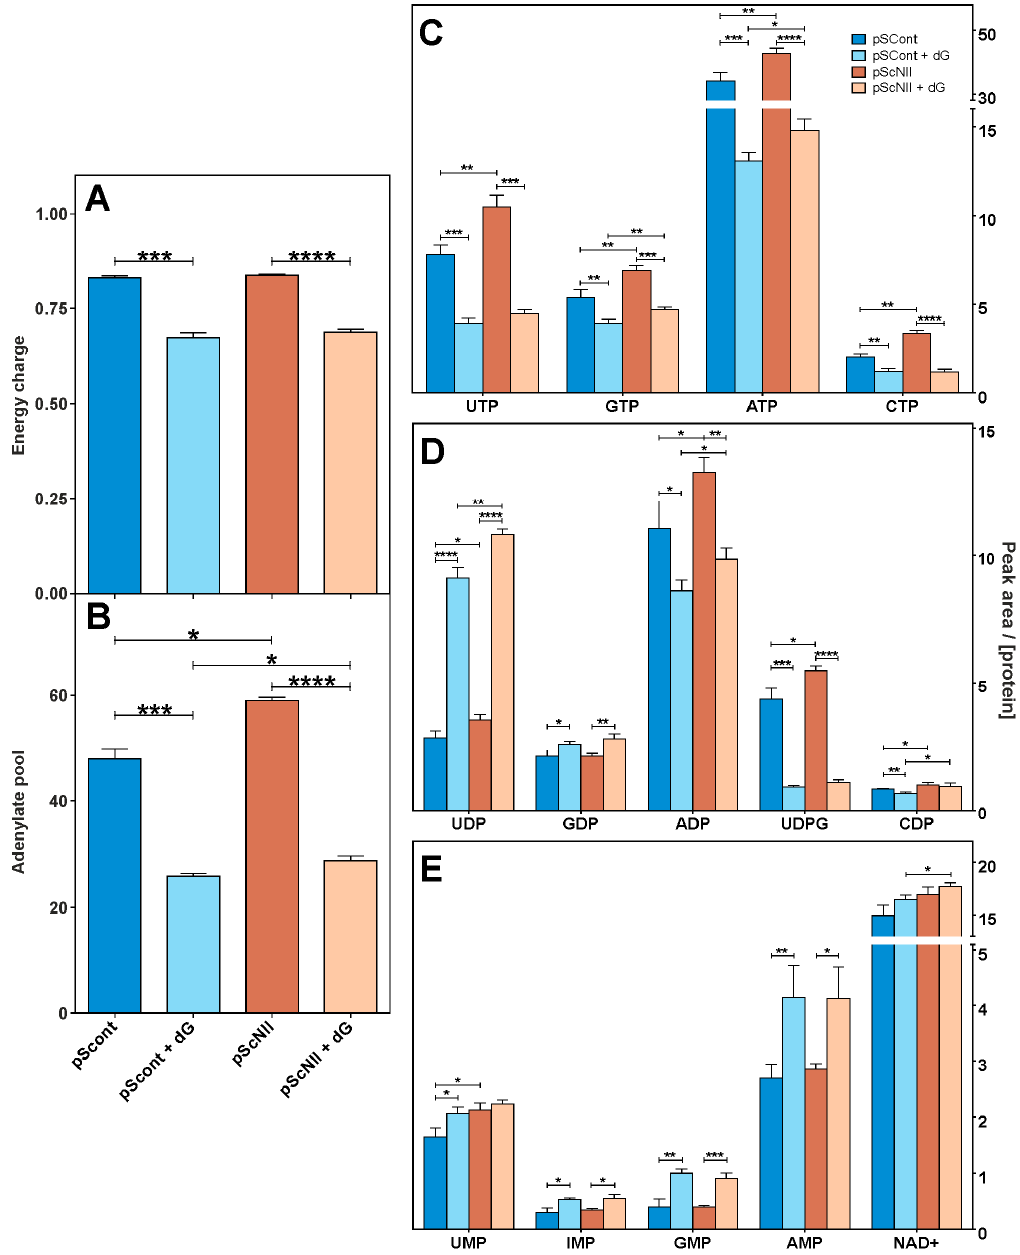
Figure 2. Effect of cN-II silencing on purine and pyrimidine nucleotide content in A549 cells. ( A )